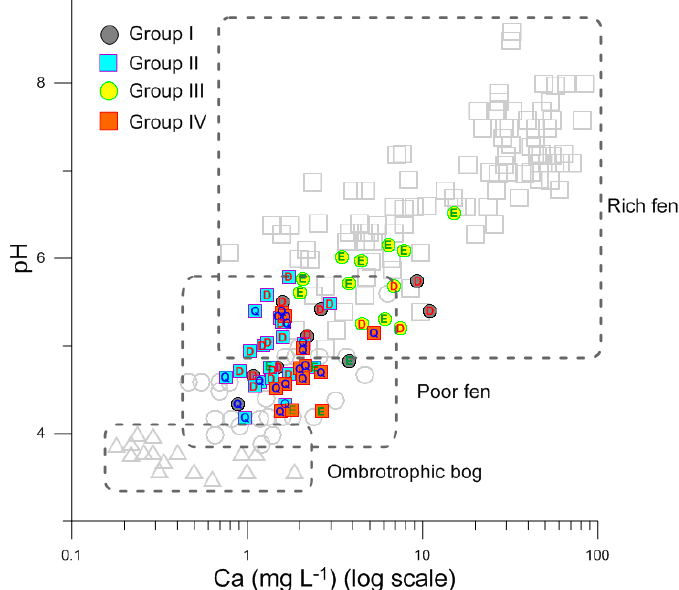
Figure 5. Calcium concentrations and pH in water samples of the three peatlands (filled shapes) and their classification according to Sj ő rs and Gunnarsson (2002) (non-filled shapes). D, Q and E represent sampling points from DJH, EXY and QZMS, respectively.